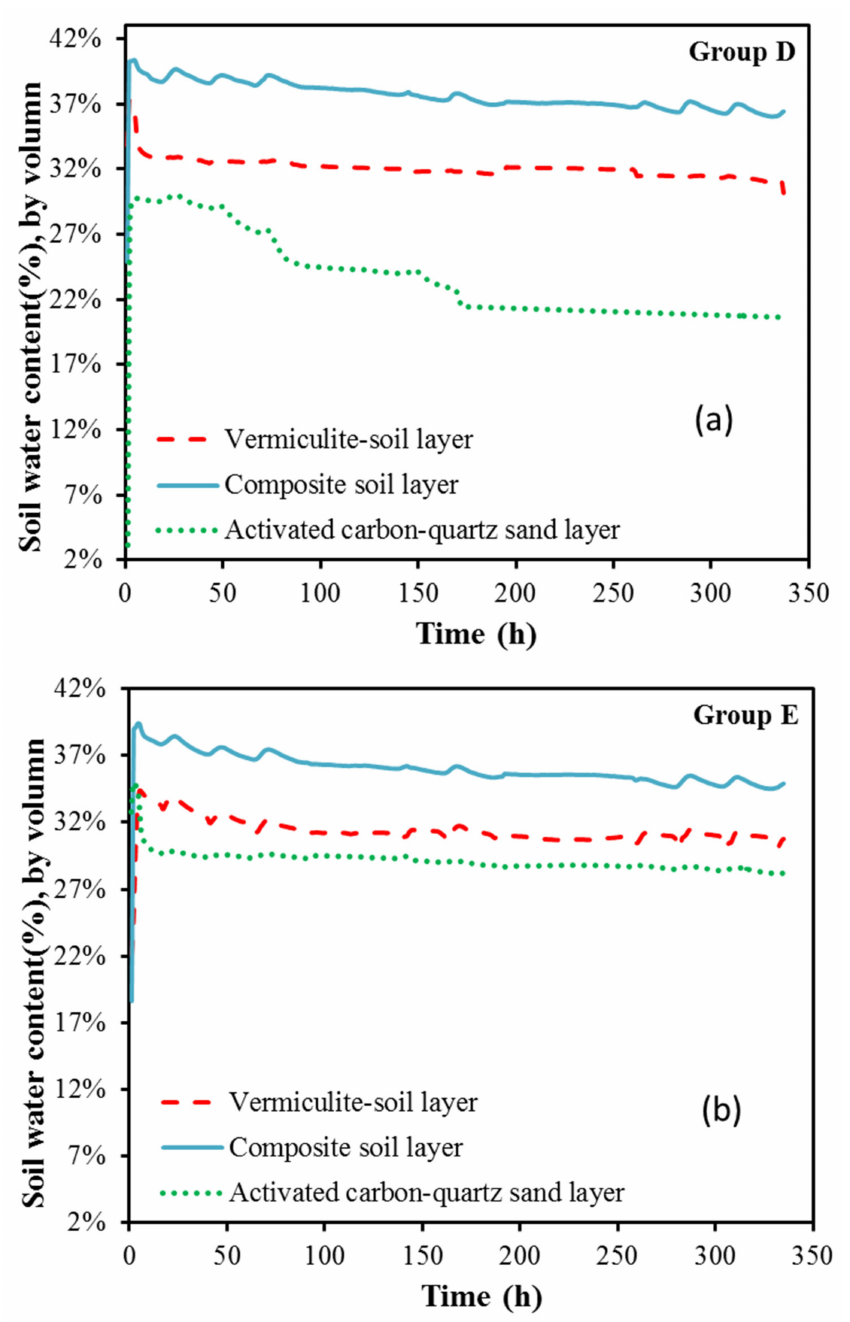
Figure 5. Soil water content for di ff erent layers under ( a ) 10-year design rainfall intensity; ( b ) 5-year design rainfall